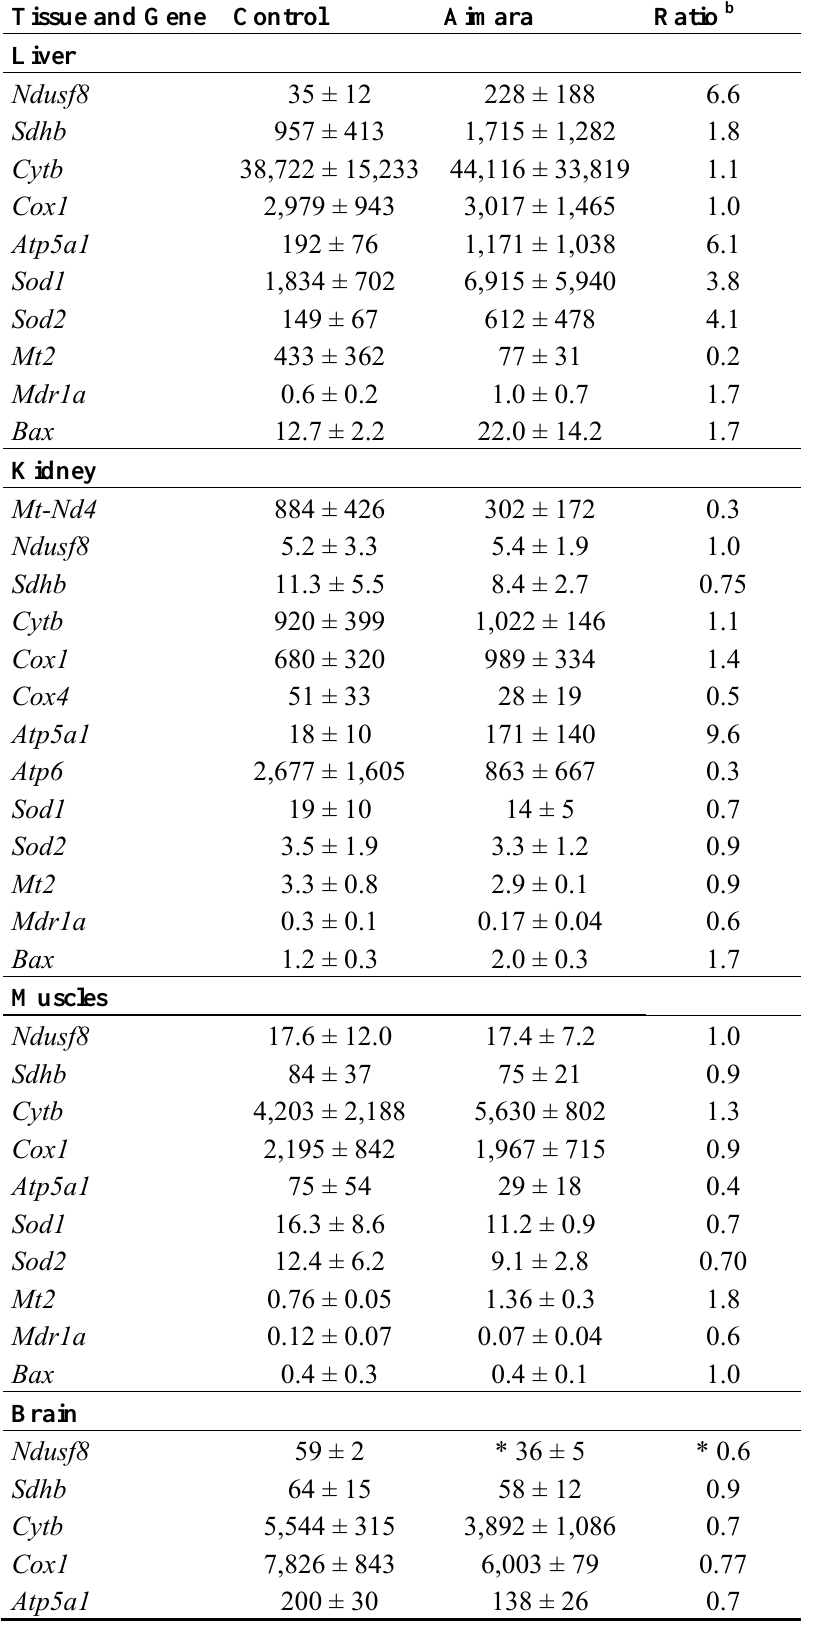
Table 11. Gene expression in tissues from KO CCL2 mice fed a fish-containing diet for three months a